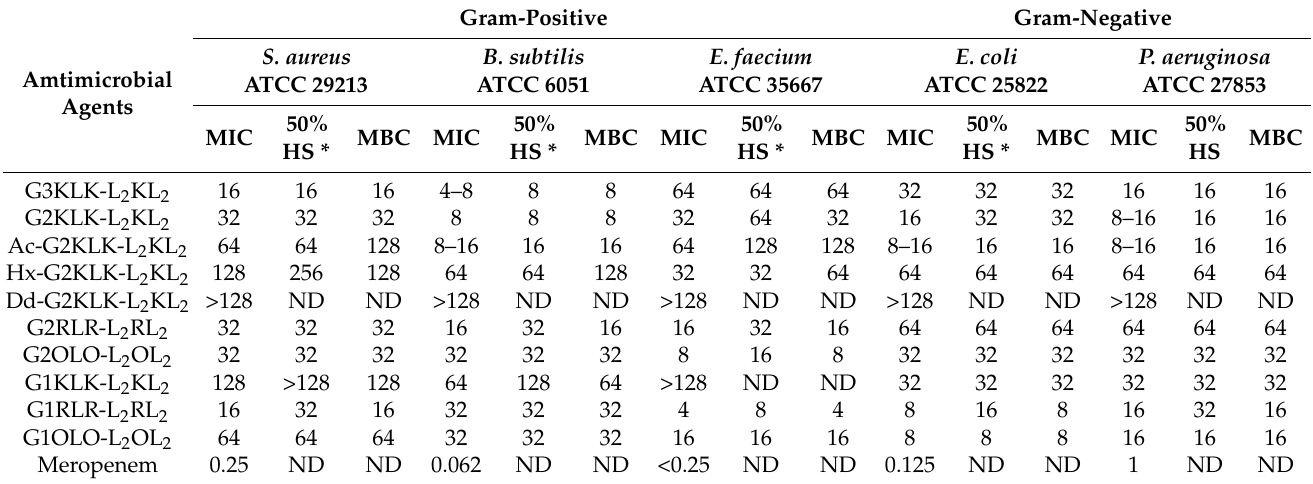
Table 2. MIC and MBC ( µ g/mL) values of the SCPDs tested on susceptible bacteria.